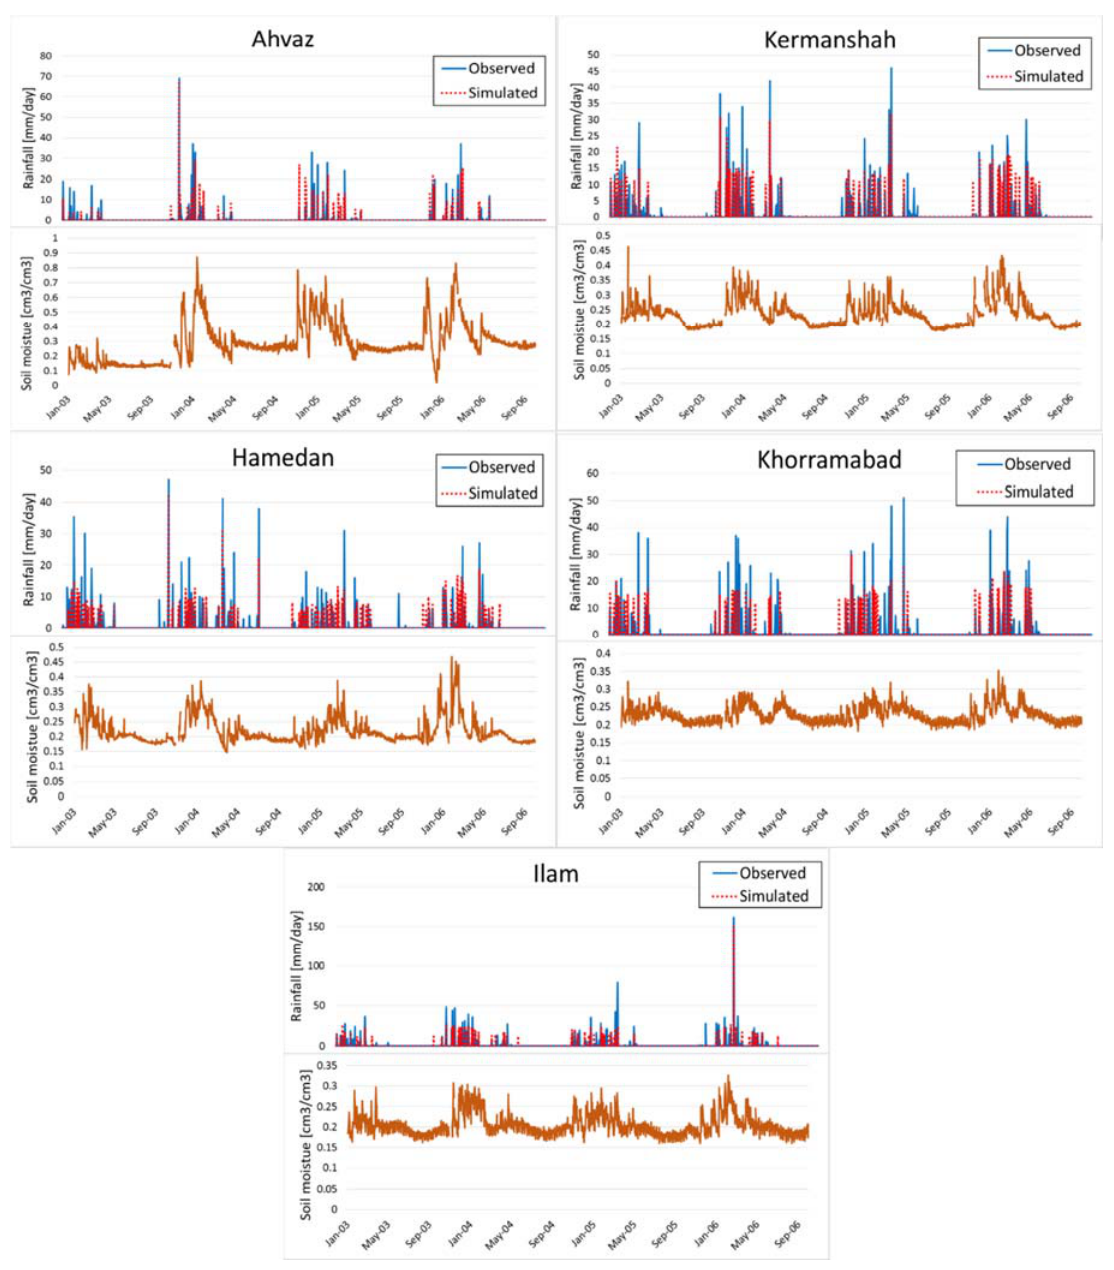
Figure 3. Observed and SM2RAIN-estimated rainfall ( upper panels ) and original Advanced Microwave Scanning Radiometer–Earth Observing System (AMSR–E soil moisture data ( lower panels ) from January 2003 to October 2006.